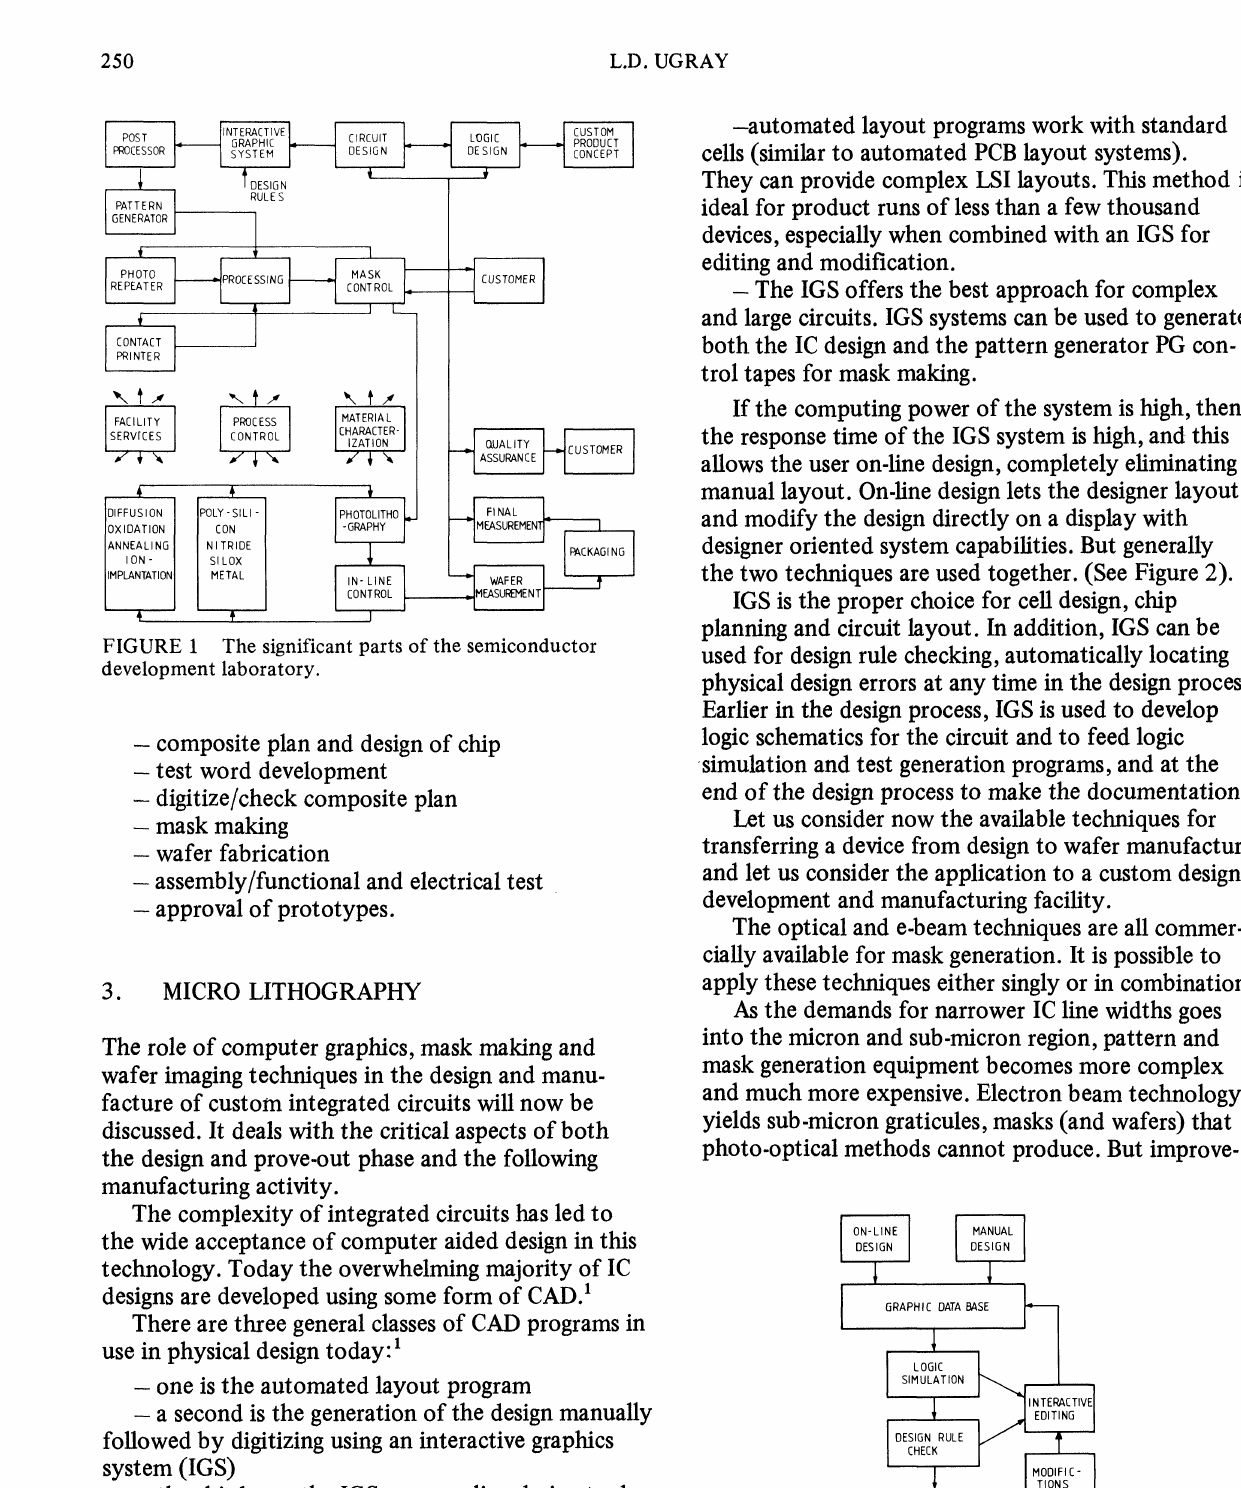
FIGURE 2 The operations in interactive graphic